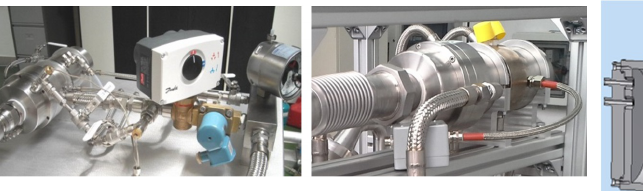
Figure 7: Oil-free turbogenerator prototypes during tests